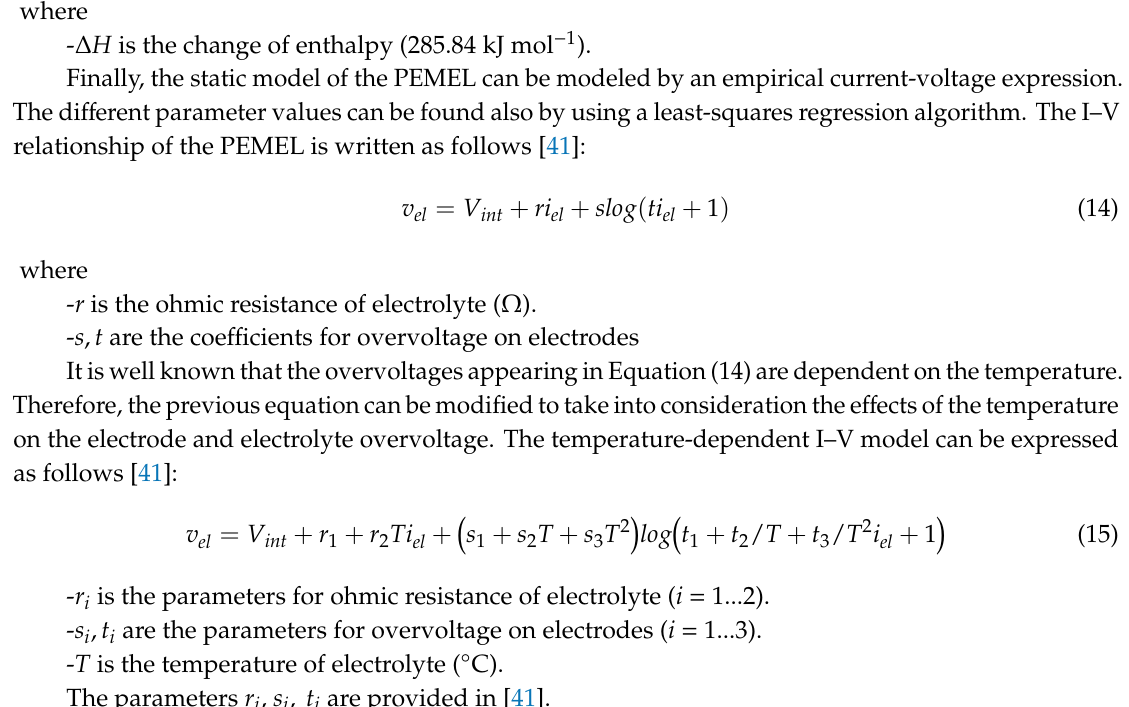
Figure 18. PEMEL stack response according to a current dynamic profile (time scale: 5 s.div − 1 ). The equivalent electrical circuit used to model the dynamic behavior of the PEMEL is shown in Figure 19. It consists of an electromotive force representing the reversible voltage ( V int ), series- connected with a resistor ( R int ) modeling the membrane, and an RC branch to emulate the losses in the anode and the dynamics [24]. In the literature, this dynamic model has been reported in other related works [9,42,43]. In [42], the authors have proposed this model based on previous works reported for fuel cells. Experimental results are provided to show the dynamics of a single-cell PEM electrolyzer, but the authors did not determine the parameters of the equivalent circuit. By comparison, in [43], the same model is presented based on [42], but only the static model is considered to be coupled with an interleaved DC–DC buck converter for control purposes. Finally, in [9], this model is presented for an alkaline electrolyzer to investigate the effects of rectifiers on the specific energy consumption and gas quality during dynamic operation.